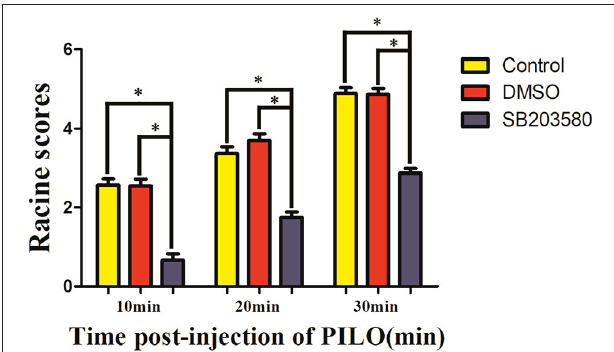
FIGURE 1 | Racine scores of different groups at different time points after the pilocarpine injection (min). * P < 0.05 compared with the control (epilepsy) and DMSO groups.